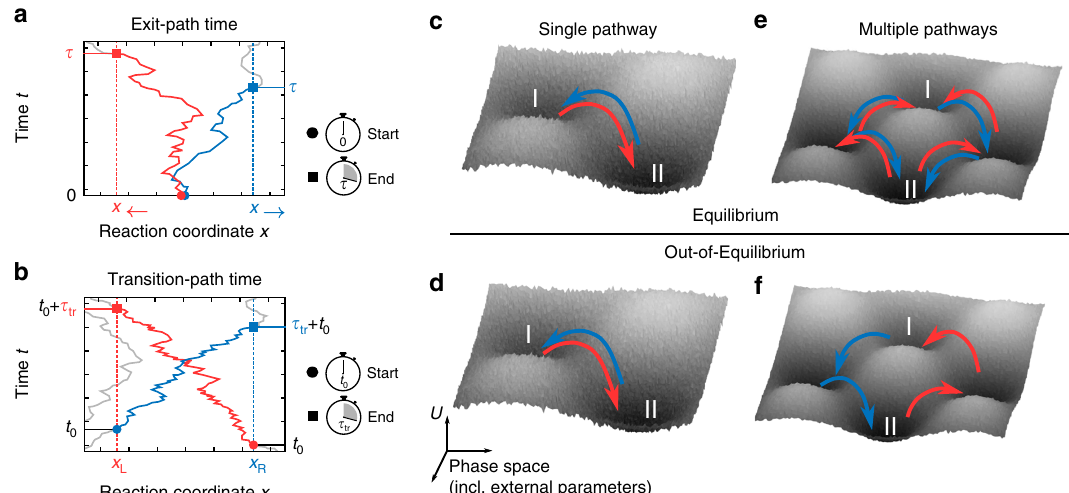
Fig. 1 Conditional exit- and direct transition-path times and pathway multiplicity with and without detailed balance. a The exit-path time τ to a given exit from a spatial interval is de fi ned as the time of fi rst-passage of that boundary (dotted line) before other boundaries are reached after initialization within the interval. b Transition-path times τ tr between the boundaries of an interval are fi rst-passage times of trajectories that start from one boundary and directly reach the opposite boundary. Trajectories that return to the same boundary (see grey trajectory) are not counted. As we explain in the text, we deliberately named the transition-path boundaries x L and x R to distinguish them from exit-path boundaries. c Illustration of (mean) transition pathways (arrows) in potential landscapes with two coordinates and a single pathway. d Sketch of out-of-equilibrium transitions that follow the same pathways and consequently do not break detailed balance. e Sketch of transitions that are time symmetric in equilibrium, despite pathway multiplicity. f The transition- path time symmetry may break down if transition paths diversify out of